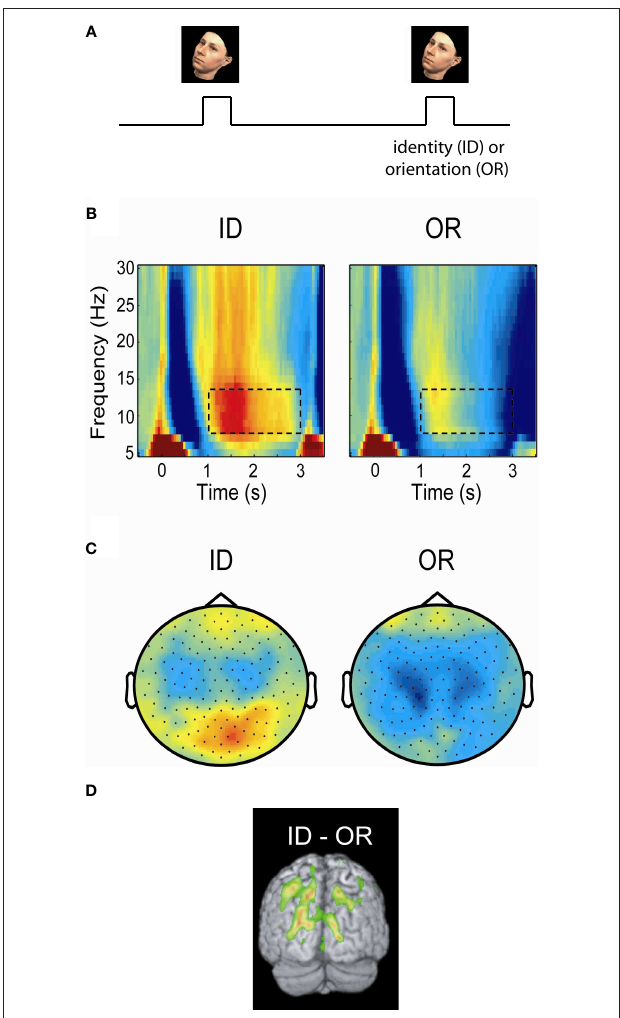
Figure 2 | Posterior alpha activity increases when the ventral stream, but not the dorsal stream, is engaged. (A) In a delayed-match-to-sample task subjects were asked to either maintained the identity (ID) or orientation (OR) of a presented face. (B) Time–frequency representations of power of the MEG signal over posterior regions measured during the task. Alpha activity increased in the ID task engaging the ventral stream, but remained low in the OR task engaging the dorsal stream. (C) The topographies of the alpha power showed that the increase in the ID condition was stronger over posterior central regions. (D) A beamforming analysis identified the alpha increase to parieto-occipital areas. The findings support the notion that the dorsal stream is suppressed by alpha activity when the ventral stream is engaged. Figure adapted from Jokisch and Jensen (2007).